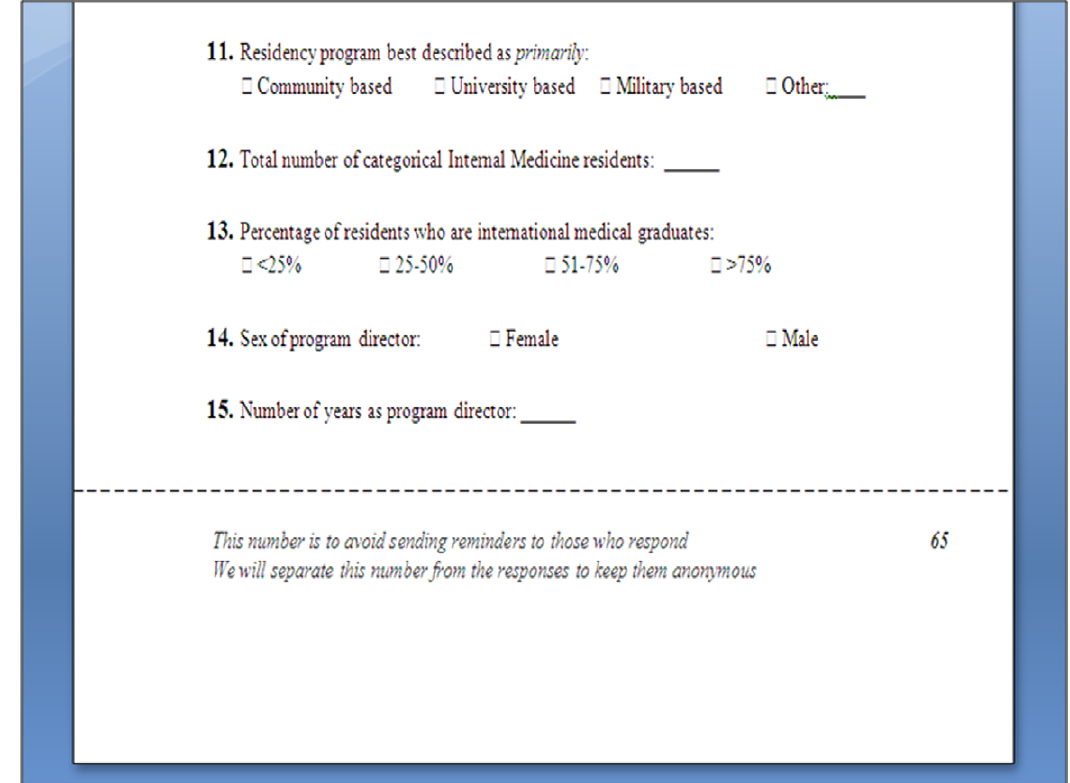
Figure 1. Image of a tracked questionnaire showing the perforation, the tracking number and a note explaining the purpose of tracking.